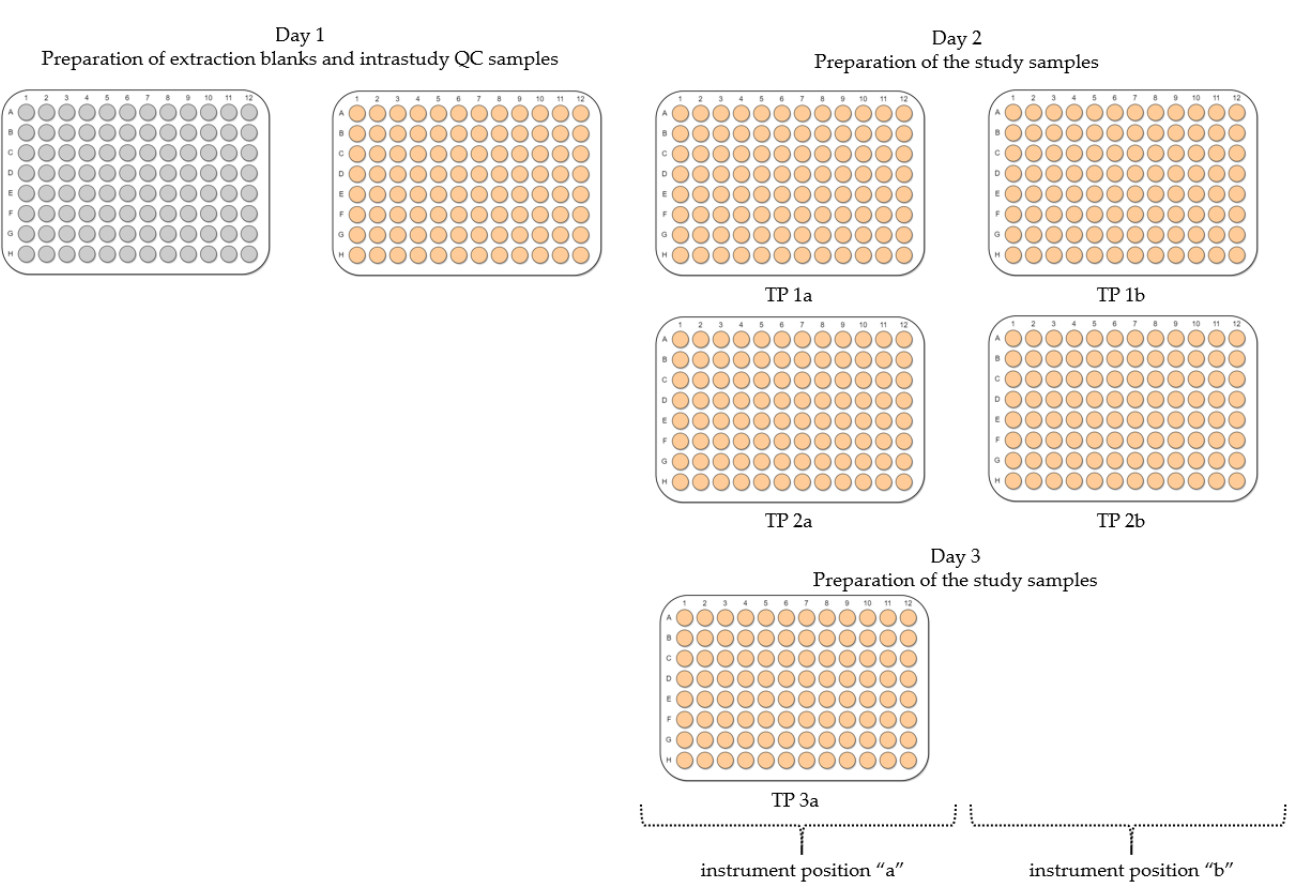
Figure 5. An overview of the experimental design for assessing the automated sample preparation workflow for in vitro metabolomics. Extraction blanks and intrastudy QC samples were prepared on day 1 of the experiment, whilst biological control samples were prepared on days 2 and 3. Conditions tested included the location of a 96-well microplate (containing frozen cells for extraction) on the instrument’s deck (indicated as “a” or “b”), day and order of metabolite extraction as well as the location of samples within a microplate (edge vs.